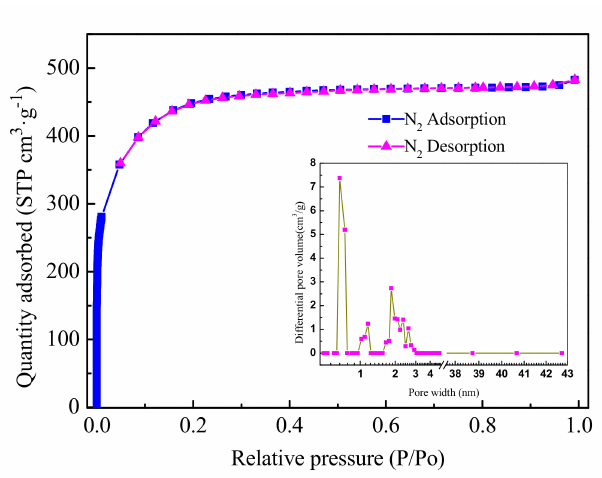
Figure 7. N 2 adsorption–desorption isotherms at 77 K and differential pore size of the optimum activated